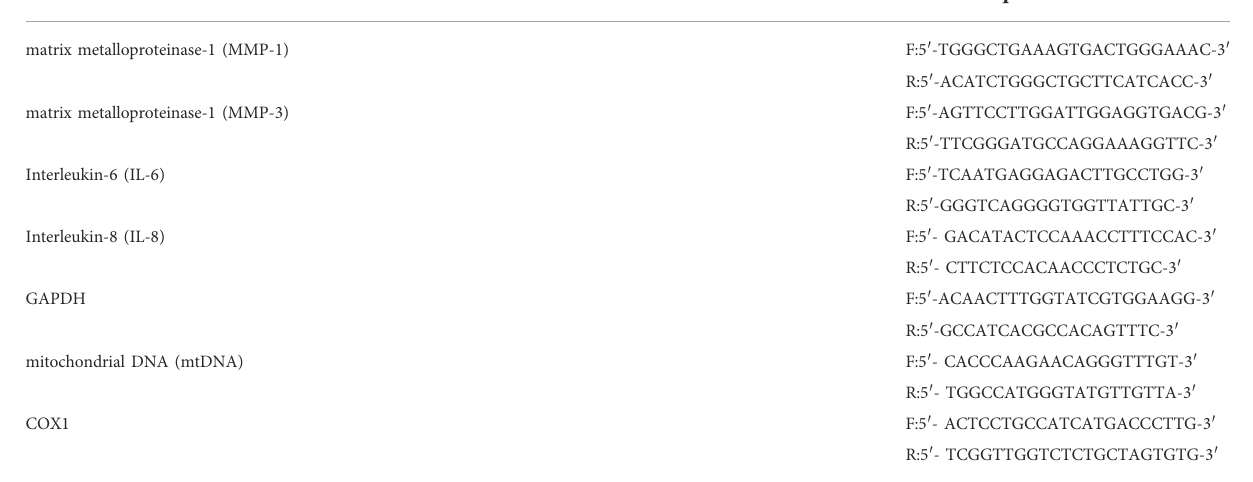
TABLE 1 Gene primer sequences for the quantitative real-time